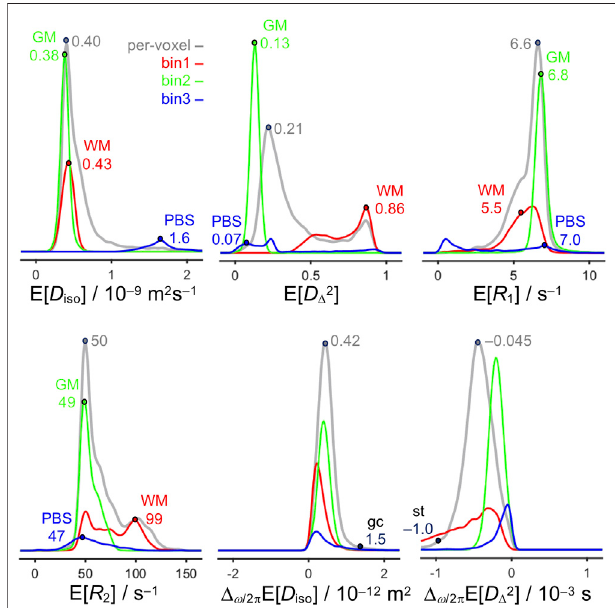
FIGURE 4 | Histograms of quantitative parameters across all voxels in the image. The histograms are obtained from the per-voxel (gray) and bin- resolved (red, green, and blue) maps of E[ D iso ], E[ D Δ 2 ], E[ R 1 ], E[ R 2 ], Δ ω /2 π E [ D iso ],and Δ ω /2 π E[ D Δ 2 ]in Figure3 andincludeweightingby S 0 , f bin1 , f bin2 , and f bin3 . The abscissas cover the same ranges as the scale bars in Figure 3 . Labeled points highlight representative values for WM in the corpus callosum, external capsule, and fi mbria, GM in the cortex, and PBS in the ventricle, as well as the granule cell layer (gcl), and stria terminalis